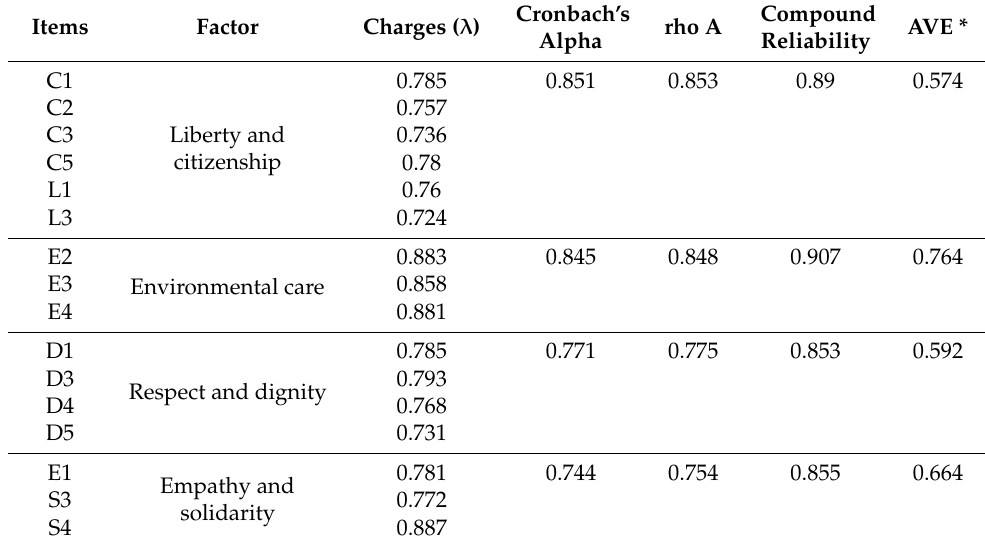
Table 4. Confirmatory Factor Analysis, reliability analysis, and convergent validity.